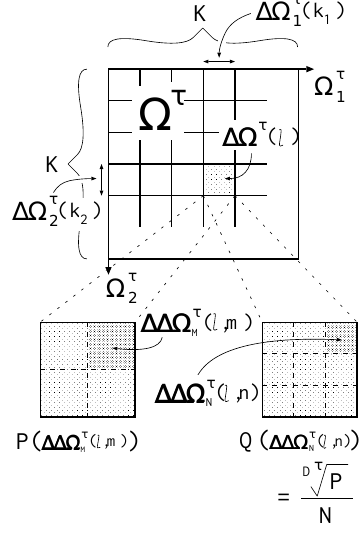
Figure 3. Division of a parameter